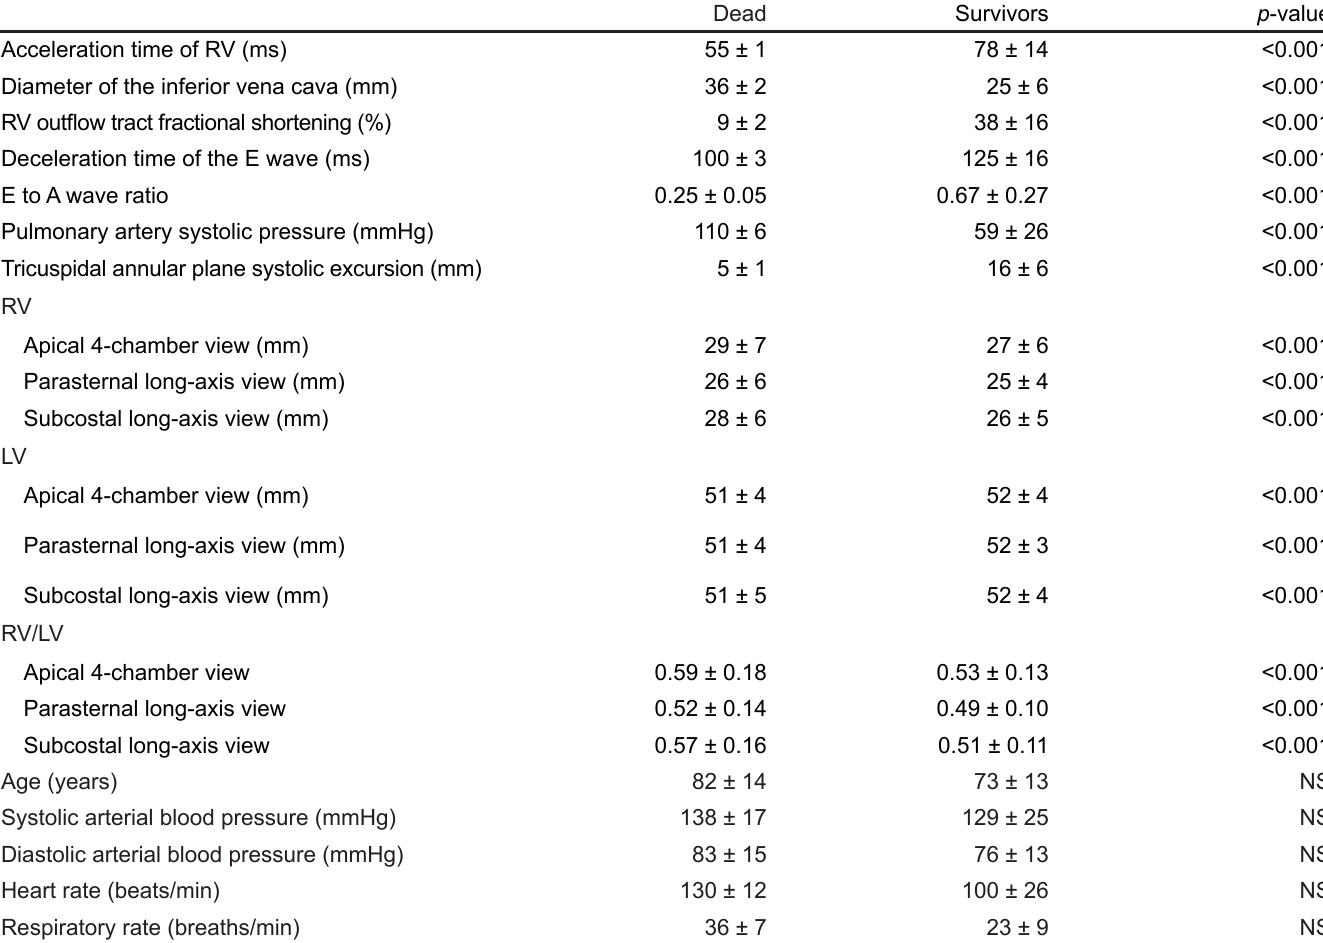
Table 3. Echocardiographic indices: age and vital signs in deceased and 30-day survivor